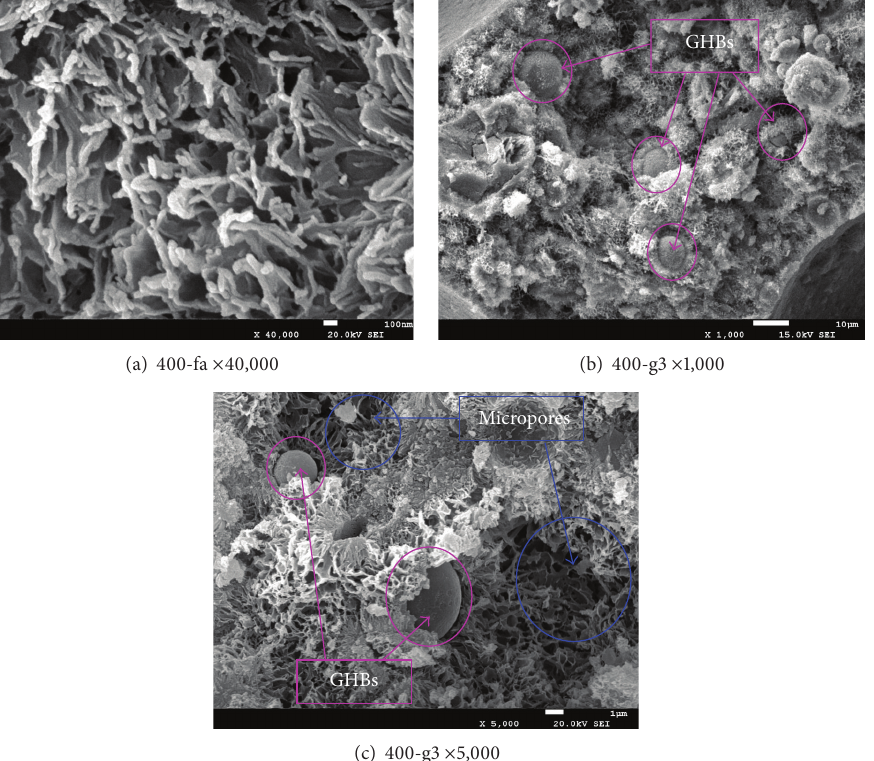
Figure 9: SEM images of the pore walls of the test specimens.